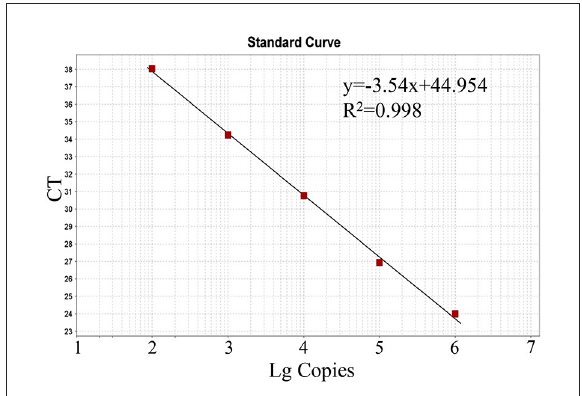
FIGURE2 Standard curve of the real-time RT-PCR for BKV based on serial dilutions of the standard RNA. The assays were linear over a 10 2 -10 6 dilution range with R 2 values of 0.998 and reaction efficiency of 91.64%.